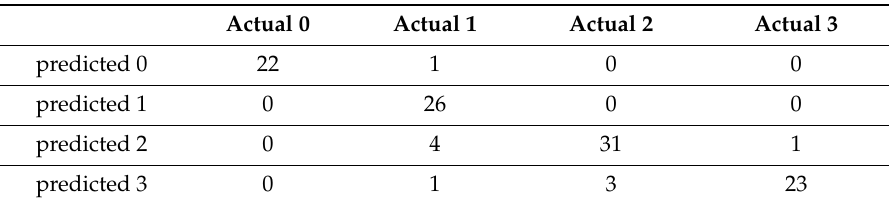
Table 9. Confusion Matrix of the Best